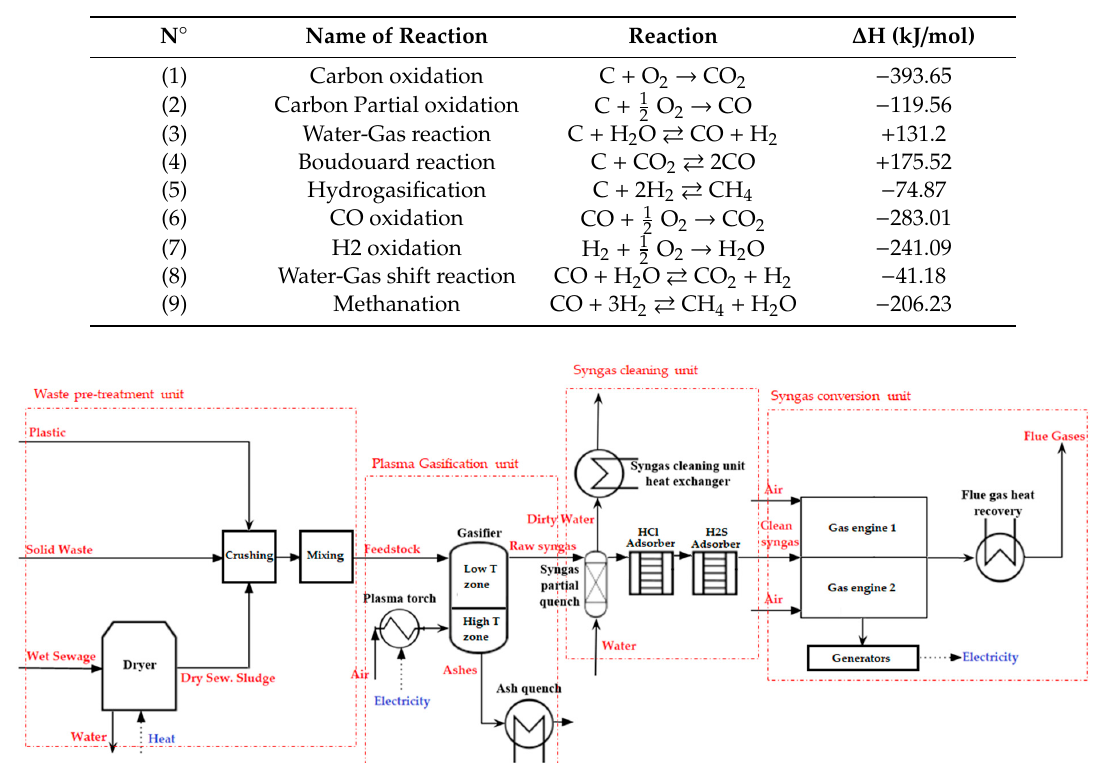
Table 3. Gasification reactions and their reaction enthalpy in standard conditions (P = 1 atm, T = 25 °C) [36].